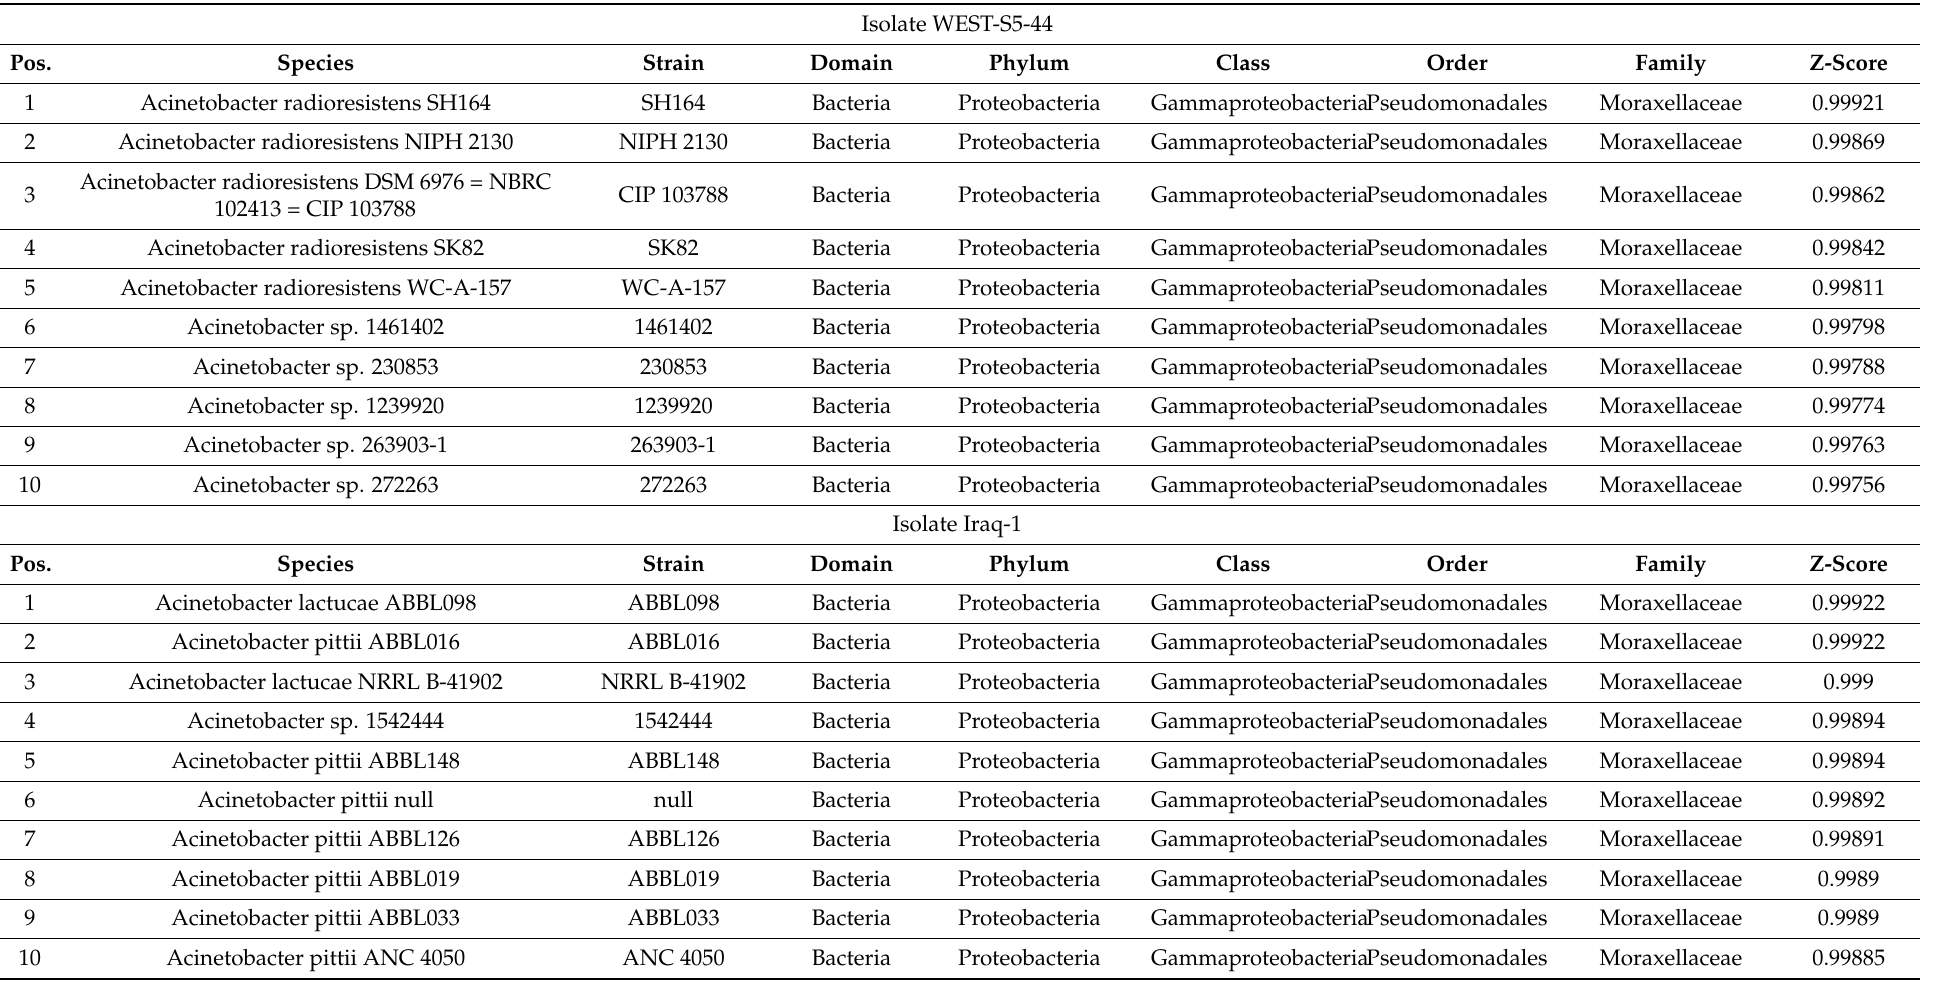
Table A1. Results of querying genomes with the TCS function of